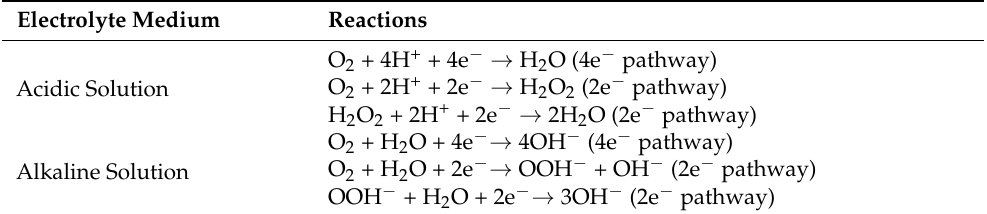
Table 3. Overall reaction equations of ORR in acidic and alkaline solutions.